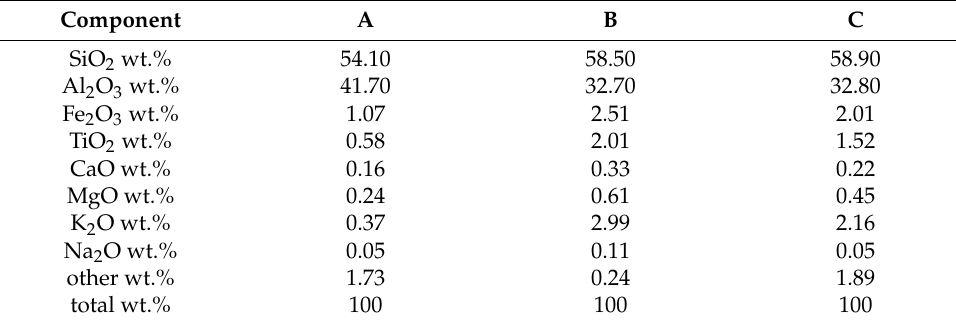
Table 1. The results of the chemical analysis of clay raw materials